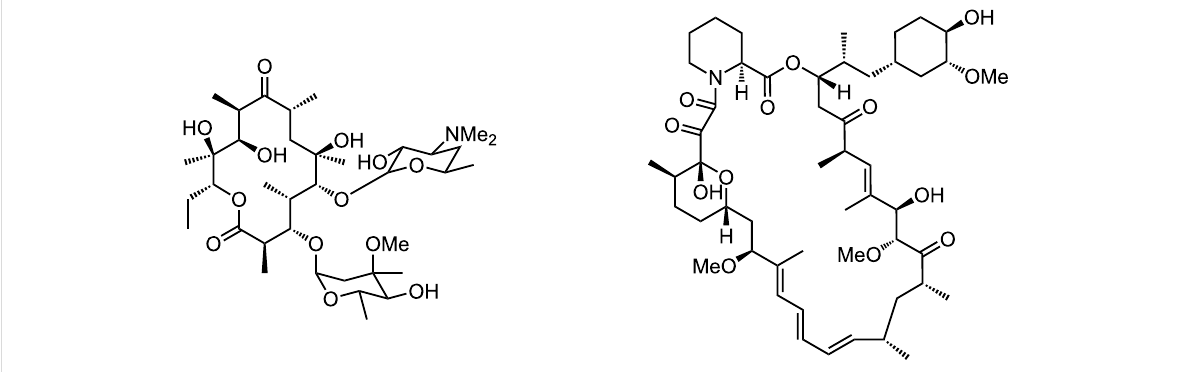
Figure 2: Structures of erythromycin (left) and rapamycin (right). In this experiment both compounds were labeled in their methyl side chains with deuterium.